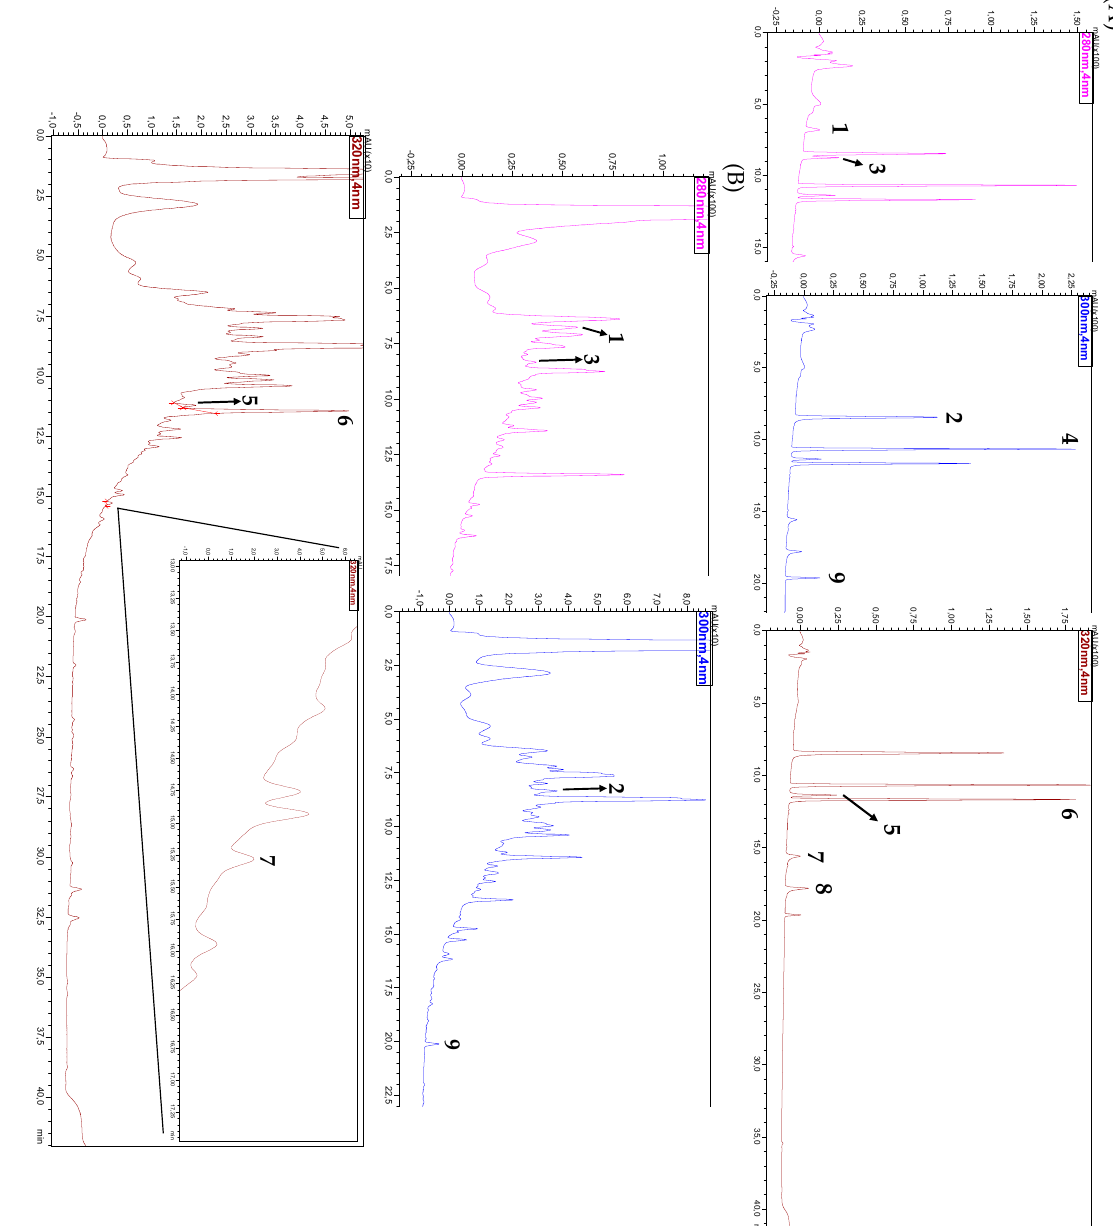
Figure 1. Chromatograms obtained by HPLC-DAD for the standard solution of the phenolic compounds at the concentration of 10 mg L − 1 ( A ) and one sample of Brazilian craft beer ( B ). Identification of the peaks: 1. catechin; 2. caffeic acid; 3. epicatechin; 4. p -coumaric acid; 5. hydrated rutin; 6. trans -ferulic acid; 7. quercetin; 8. kaempferol; 9. formononetin (pink = 280 nm; blue = 300 nm; and brown = 320